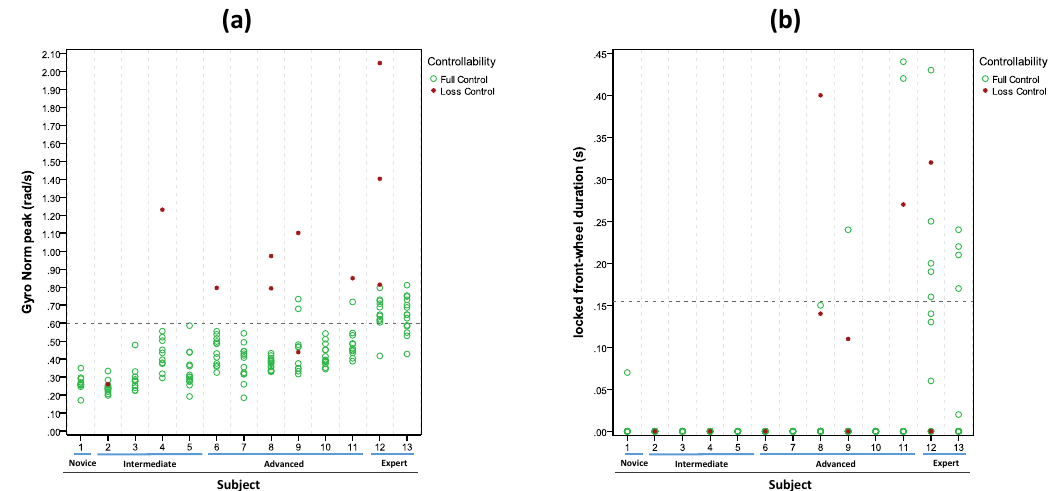
Figure 5. Scatter plot by skill level (dotted line sets the threshold for less skilled riders): ( a ) Gyro Norm Max and ( b ) locked front-wheel duration.